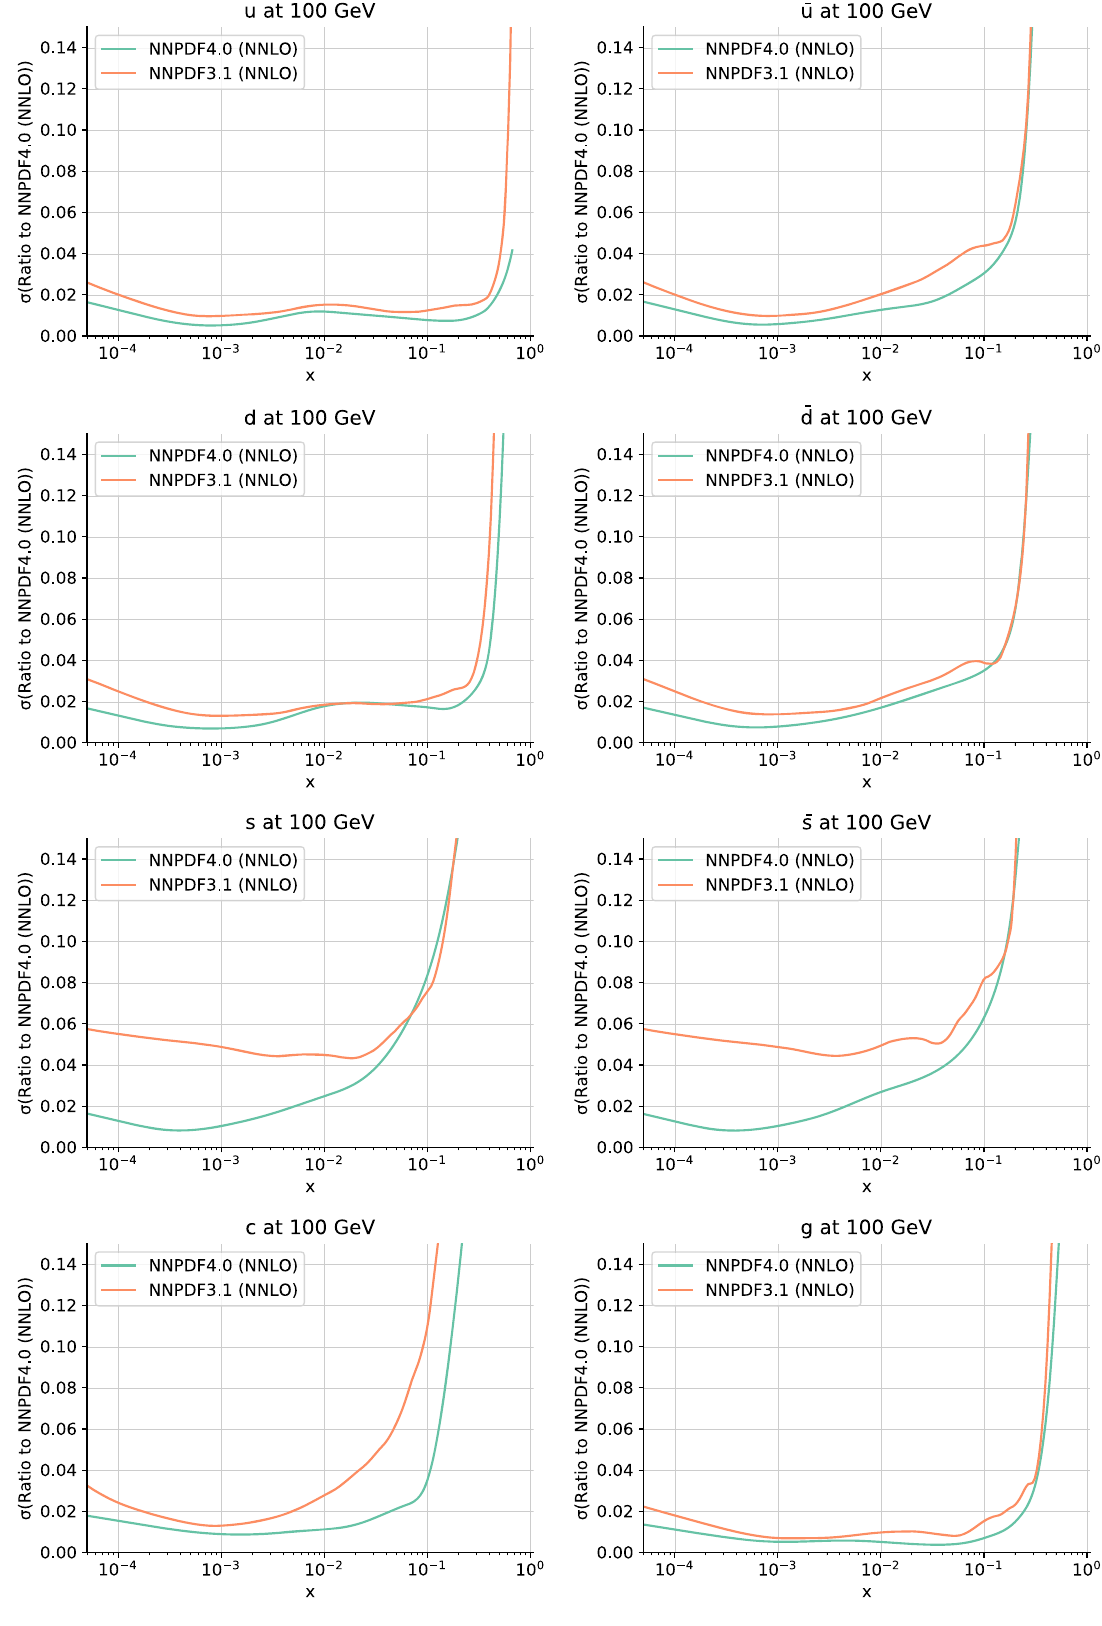
Fig. 18 Same as Fig. 17 but for one-sigma relative